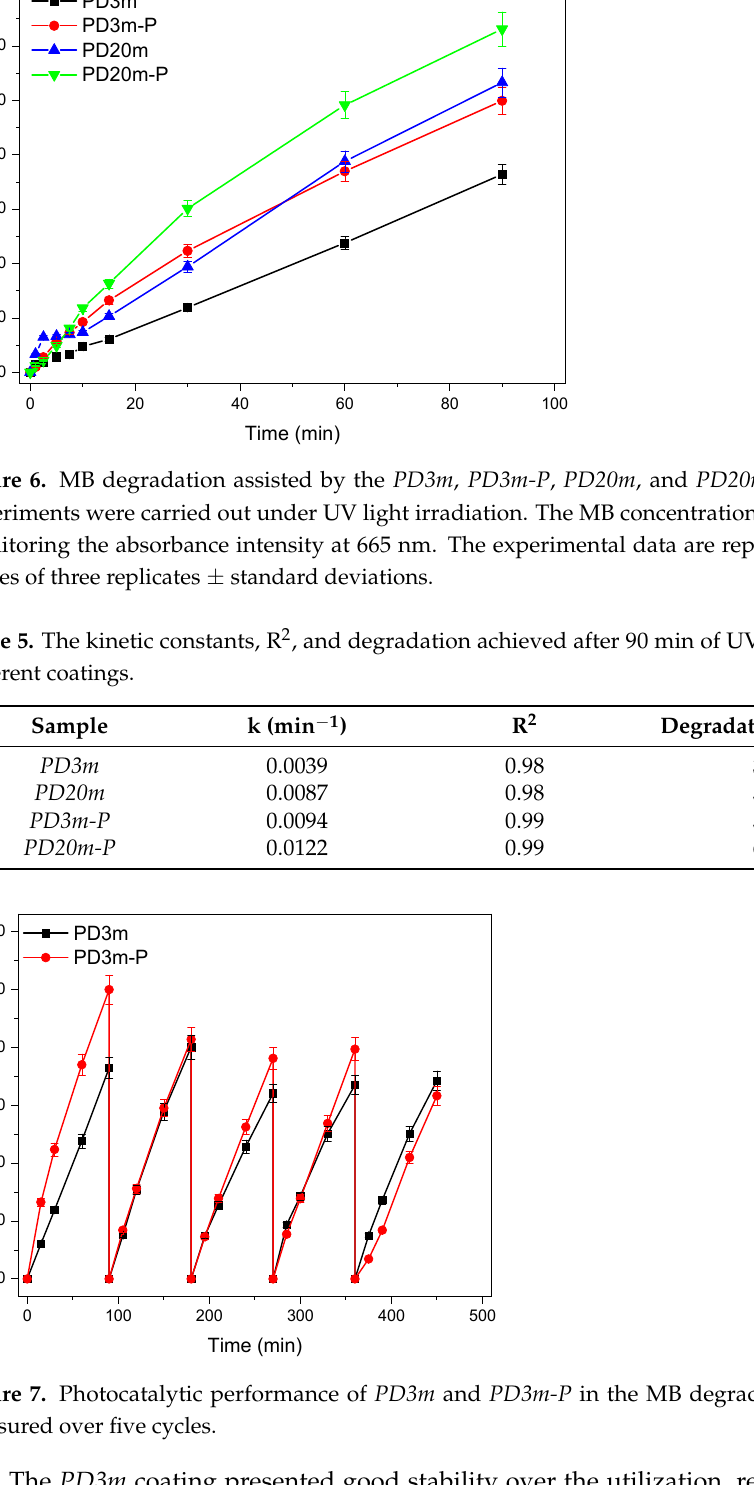
Figure 6. MB degradation assisted by the PD3m , PD3m-P , PD20m , and PD20m-P coatings. The experiments were carried out under UV light irradiation. The MB concentration was evaluated by monitoring the absorbance intensity at 665 nm. The experimental data are reported as the mean values of three replicates ± standard deviations.